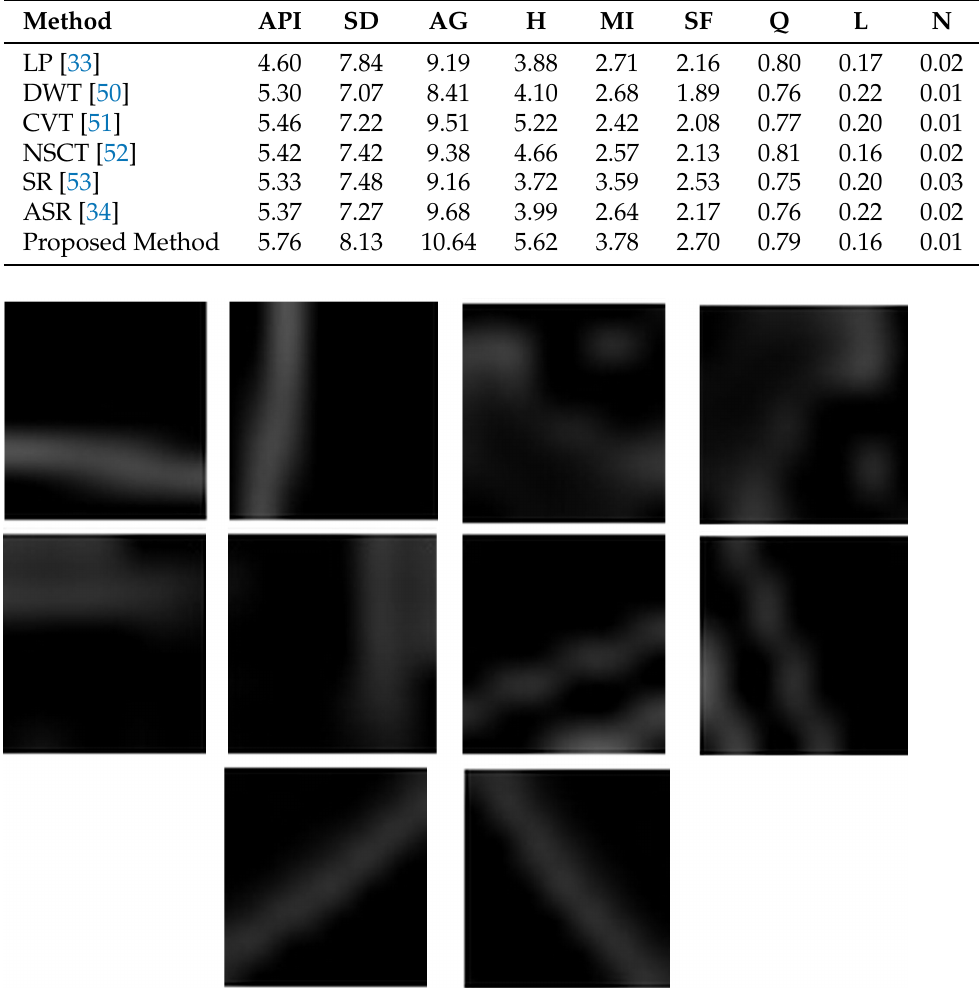
Figure 11. Dictionary random samples from a single-source